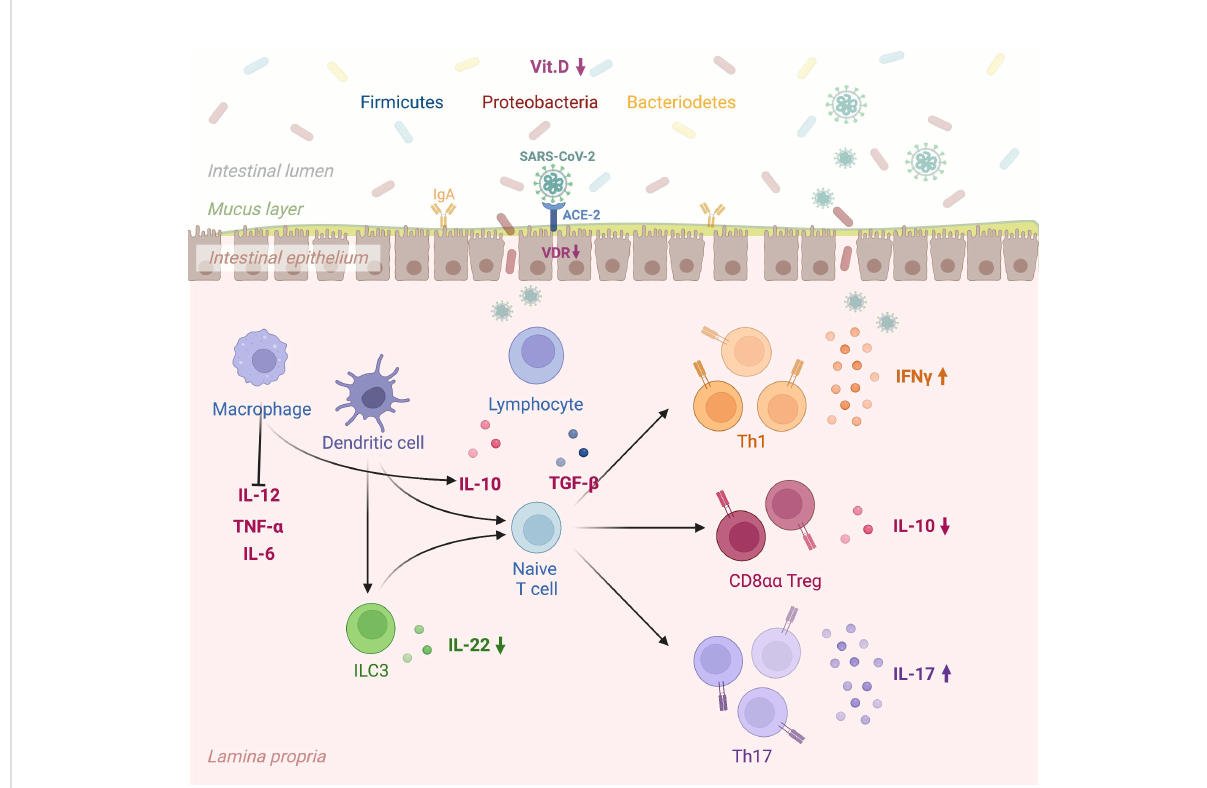
FIGURE 2 A schematic view linking vitamin D de fi ciency, the gut microbiome, and the intestinal immune response to COVID-19. “ Created with BioRender.com ” (Agreement number: ON24KBPV47, Academic License). Vitamin D promotes the expression of gap junction proteins within the gastrointestinal tract, which maintain barrier integrity and thus prevent tissue entry by bacteria from the gut microbiome. The VDR-vitamin D endocrine system can modulate acquired and innate immune system functions in viral infections. Speci fi cally, SARS-COV-2 infection of the intestinal epithelium results in rapid viral replication. In the presence of vitamin D de fi ciency intestinal dendritic cells activated by viruses migrate to lymph nodes, where they earn an enhanced capacity to present antigen or T cell activation (e.g., CD4, CD8, TH, T reg, and ILC). Lower Vitamin D levels alter immune balance promoting pro-in fl ammatory cytokines and T Helper cell type-1 (TH1), 17 (TH17) and suppressing T regulatory response. Vit.D: Vitamin D; SARS CoV 2: Severe Acute Respiratory Syndrome Coronavirus 2; ACE-2: Angiotensin-Converting Enzyme 2; VDR: Vitamin D Receptor; IgA: Immunoglobulin A; IL-12: Interleukin 12; TNF- a : Transforming Growth Factor; IL-6: Interleukin-6; ILC3: Type 3 Innate Lymphoid Cells; IL-22: Interleukin 22; IL-10: Interleukin 10; TGF- b : Transforming Growth Factor Beta; Th1: Type 1 T Helper Cell; CD8 aa T reg: Cluster of Differentiation 8 aa T Regulatory Cell; Th17: Type 17 T Helper Cell; IFN g : Gamma Interferon; IL-17: Interleukin 17. VDR: vitamin D